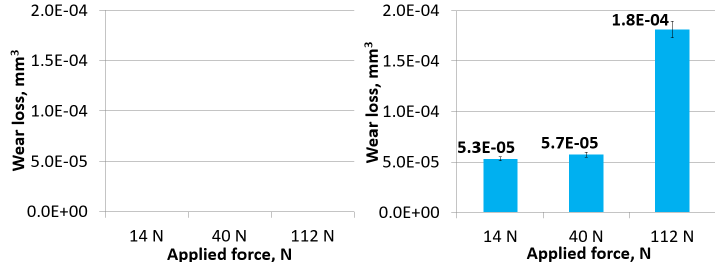
Figure 10. Disc wear loss for SS/DLC in oil ( Left ) and water ( Right